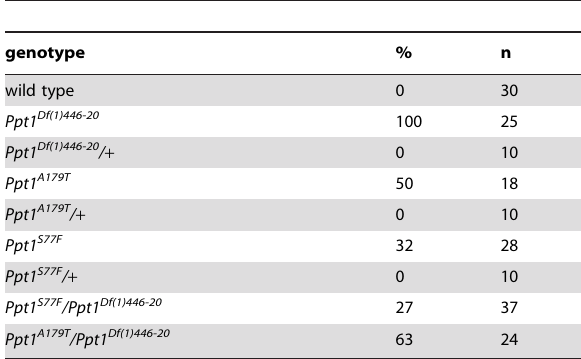
Table 2. Penetrance of EVE + RP2 phenotype in Ppt1 -